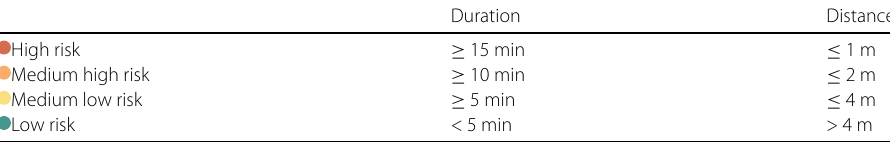
Table 3 Description of the contacts resulting from the aggregation procedure. For each camp, we report the total number of contacts, the average number of the measurements for each contact, the number of groups and activities in the camp, and the number and percentage of the contacts that are uniquely associated with an activity. For DAY - PRI and DAY - INT , we report both the number of activities, and the number of activities considered for the analysis (in parenthesis) ID Num. Contacts Average Measurements Num. Groups Num. Activities Activity-tagged per Contact contacts AM - PRI 7259 5.80 3 8 6833 (94.13 %) DAY - PRI 7561 8.48 2 5 (4) 6774 (89.59 %) DAY - INT 3485 16.40 1 9 (7) 3485 (100.00 %) Table 4 Risk levels of contagion defined on the basis of duration of exposure and physical distance Duration Distance High risk ≥ 15 min ≤ 1 m Medium high risk ≥ 10 min ≤ 2 m Medium low risk ≥ 5 min ≤ 4 m Low risk < 5 min > 4